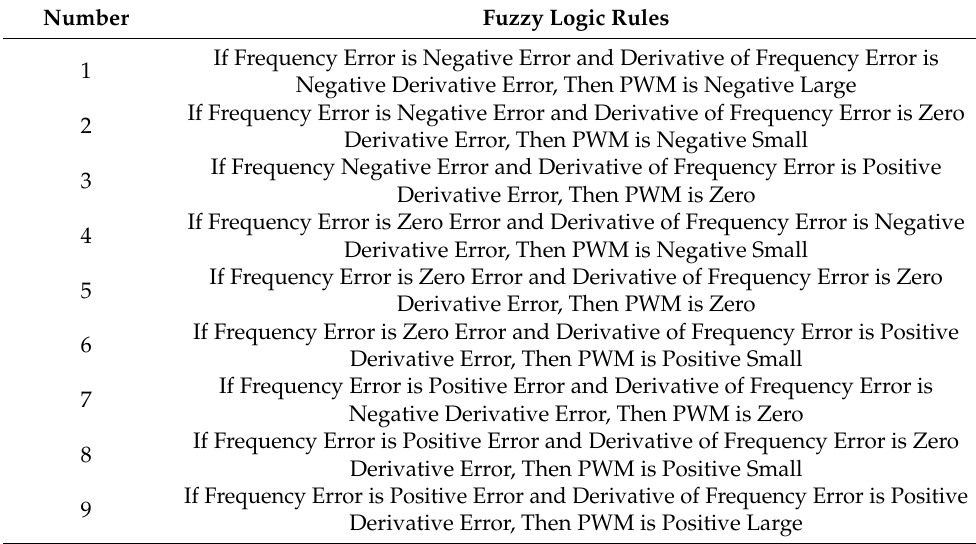
Table 2. Fuzzy logic operation with “If-Then” rules.